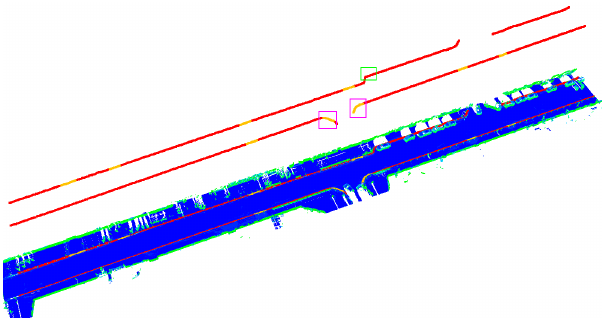
Figure 13: An example of surface modeling in a curb ramp